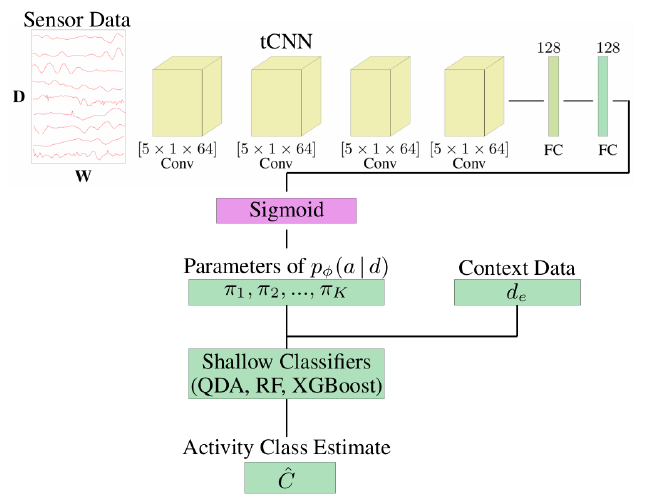
Figure 6. Activity recognition architecture. The pre-trained neural network predicts high-level movement descriptors (attributes). Together with the context data, they are used by a shallow classifier to predict activity classes. Figure adapted from